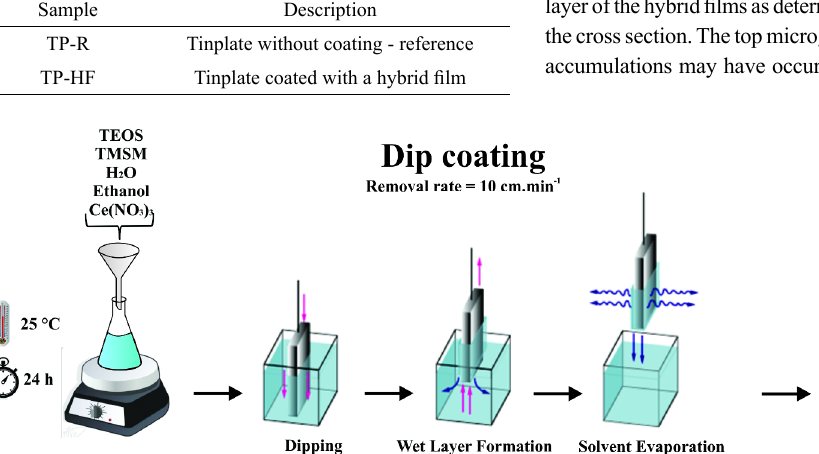
Figure 2. Flowchart of the experimental